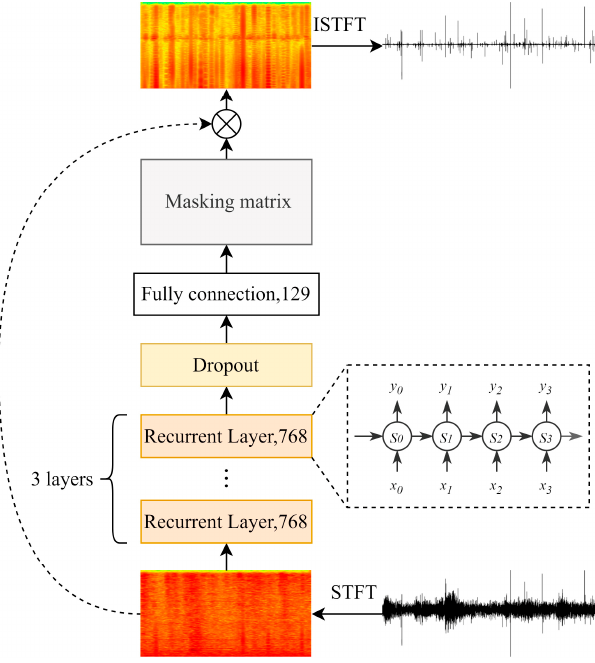
Figure 5. The framework of FDD-Nets.